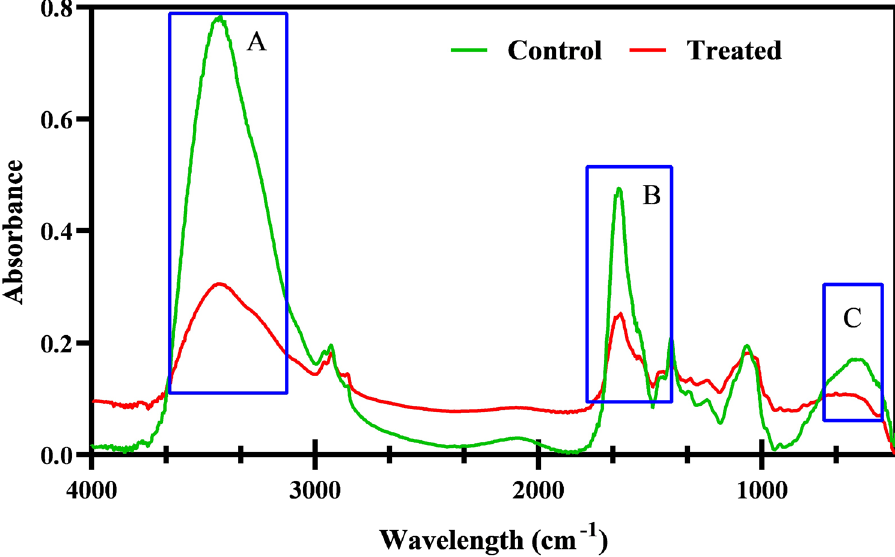
Figure 11. FTIR analysis of C. albicans EPS . Spectral region ranging from 4000–400 cm −1 represent the control and treated samples. Highlighted region portray the decrease in catechol treated EPS component such as ( a ) amide bonds of peptides (3200–3800 cm − 1), ( b ) proteins (1500–1800 cm −1 ) and ( c ) polysaccharides (200– 600 cm −1 ) of microbial cell wall.